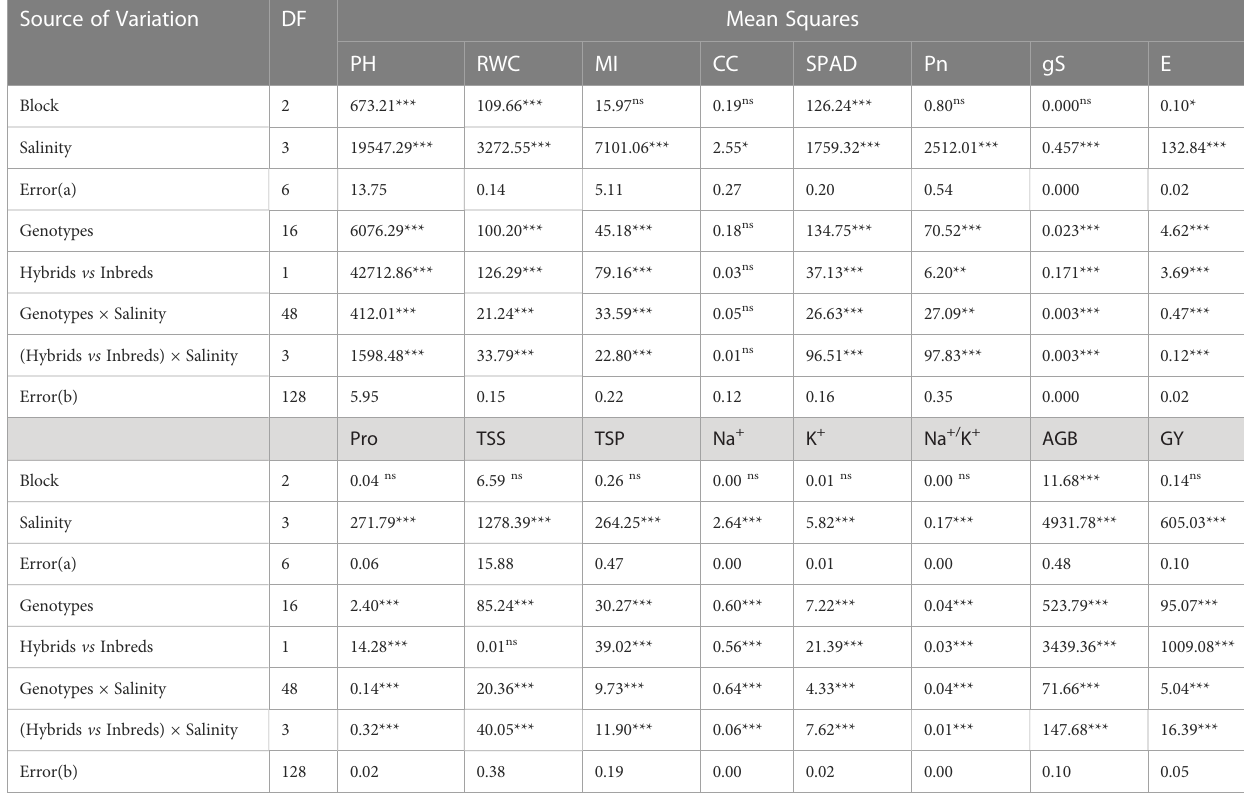
TABLE 1 Analysis of variance (ANOVA) for morpho – physiological traits in pearl millet under salinity stress. Source of Variation DF Mean